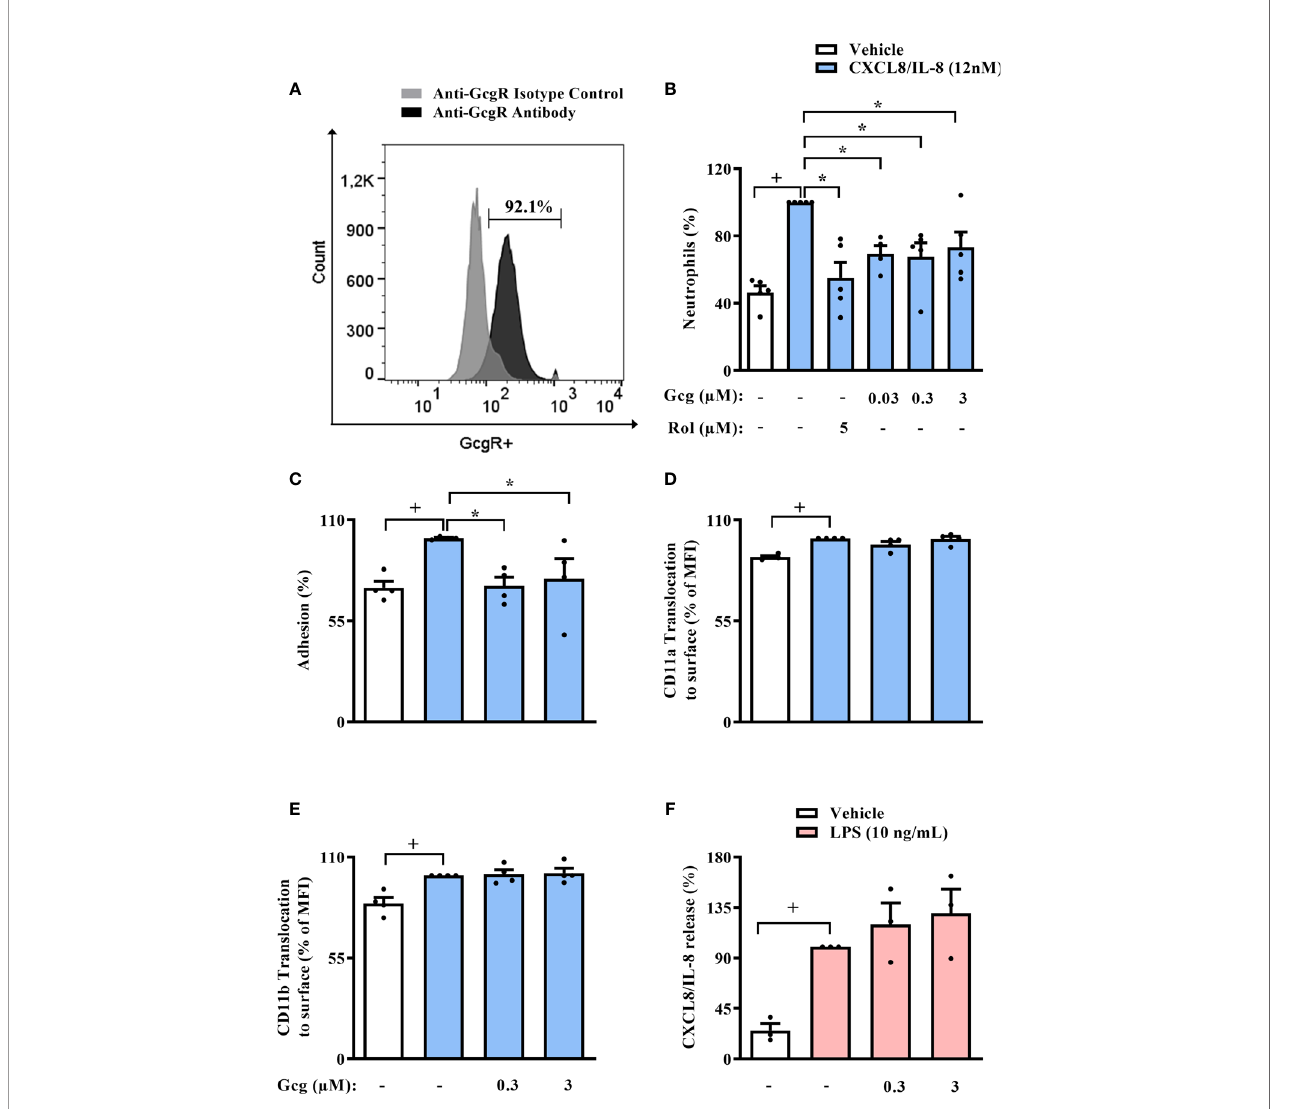
FIGURE 7 | Glucagon inhibits human neutrophil migration and adhesion in vitro , without modifying CD11a nor CD11b surface expression and release of CXCL8/IL- 8. (A) Histogram of GcgR expression on the surface of human neutrophils isolated from healthy individuals. Data are representative of 3 healthy individuals. The gray histogram shows isotype control staining, and the black histogram shows speci fi c staining with polyclonal antibody anti-GcgR (PE). In this assay, 92.1% of neutrophils were GcgR + and MFI value for anti-GcgR antibody was 218, while MFI value for isotype control was 76.1. Representative density plots of GcgR expression and isotype control staining on neutrophils isolated from human blood are reported in SM Figure S7 . (B – E) Effect of glucagon on CXCL8/IL-8-induced (12 nM) chemotaxis; adhesion; and translocation of CD11a and CD11b to surface of neutrophils obtained from human blood in vitro , respectively. (F) Effect of glucagon on LPS (10 ng/mL)-induced CXCL8/IL-8 release by human neutrophils in vitro . For (B) , neutrophils from 5 healthy individuals were obtained. Cells were pretreated 1h with glucagon, rolipram or vehicle in vitro and then let to migrate for 2h towards CXCL8/IL-8 (12 nM) or medium in a chemotaxis chamber. For (C) , neutrophils from 4 healthy individuals were labeled with calcein-AM and pretreated 40 min with glucagon or medium in vitro . Then, neutrophils were stimulated with CXCL8/IL-8 (12nM) or medium for 1h in vitro and added to previous LPS (1 µg/mL)-activated-HUVECs wells for 1h. Control cells were HUVEC stimulated with LPS and neutrophils incubated with vehicle (medium), while stimulated cells were LPS-provoked HUVEC and CXCL8/IL-8-stimulated neutrophils. The number of adherent neutrophils to HUVECs was determined using a fl uorescence plate reader. For (D, E) , neutrophils from 4 healthy individuals were obtained. Cells were treated 40 min with glucagon in vitro and then stimulated with CXCL8/IL-8 (12 nM) for 1h in vitro . Translocation of CD11a and CD11b to cell surface was represented as the percentage of MFI values that were obtained by FACS. Representative density plots of CD11a and CD11b expression on human neutrophils surface are reported in SM Figures S8 , S9 , respectively. For (F) , neutrophils from 3 healthy individuals were obtained. Cells were pre-treated 1h with glucagon in vitro and then stimulated with LPS (10 ng/mL) for 2 h in vitro . CXCL8/IL-8 levels were quanti fi ed by ELISA. The vehicles used were DMSO 0.1% or medium to rolipram and glucagon, respectively. Each human sample was equally distributed to all experimental groups. Sample results were obtained by blinded and randomized analysis. Each value represents the mean ± S.E.M. The statistical analysis was performed by one-way ANOVA, followed by Newman – Keuls – Student ’ s t-test. Results from (A, B) are representative of two individual assays. Results from (C – F) are representative of one individual assay. + P < 0.05 compared to non-stimulated cells. * P < 0.05 compared to stimulated cells. Gcg, Glucagon; Rol,